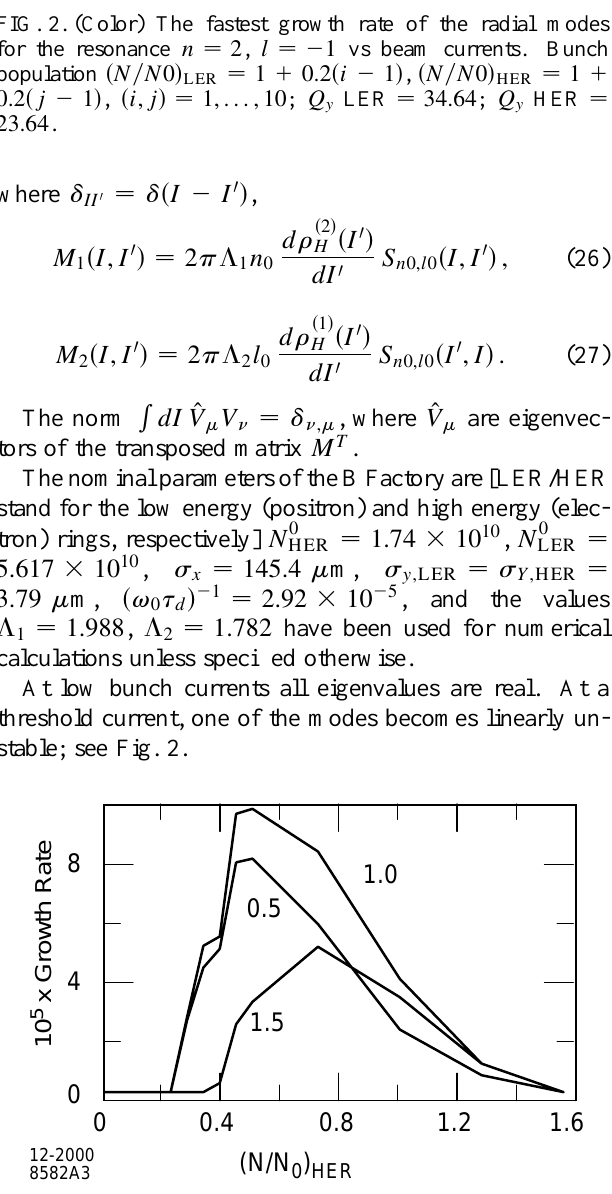
FIG. 3. The maximum growth rate of radial modes for the resonance n (cid:1) 2 , l (cid:1) 2 3 . Q y LER (cid:1) 34.57 , Q y HER (cid:1) 23.62 , nominal bunch population. Beam offset is shown in units of s y .